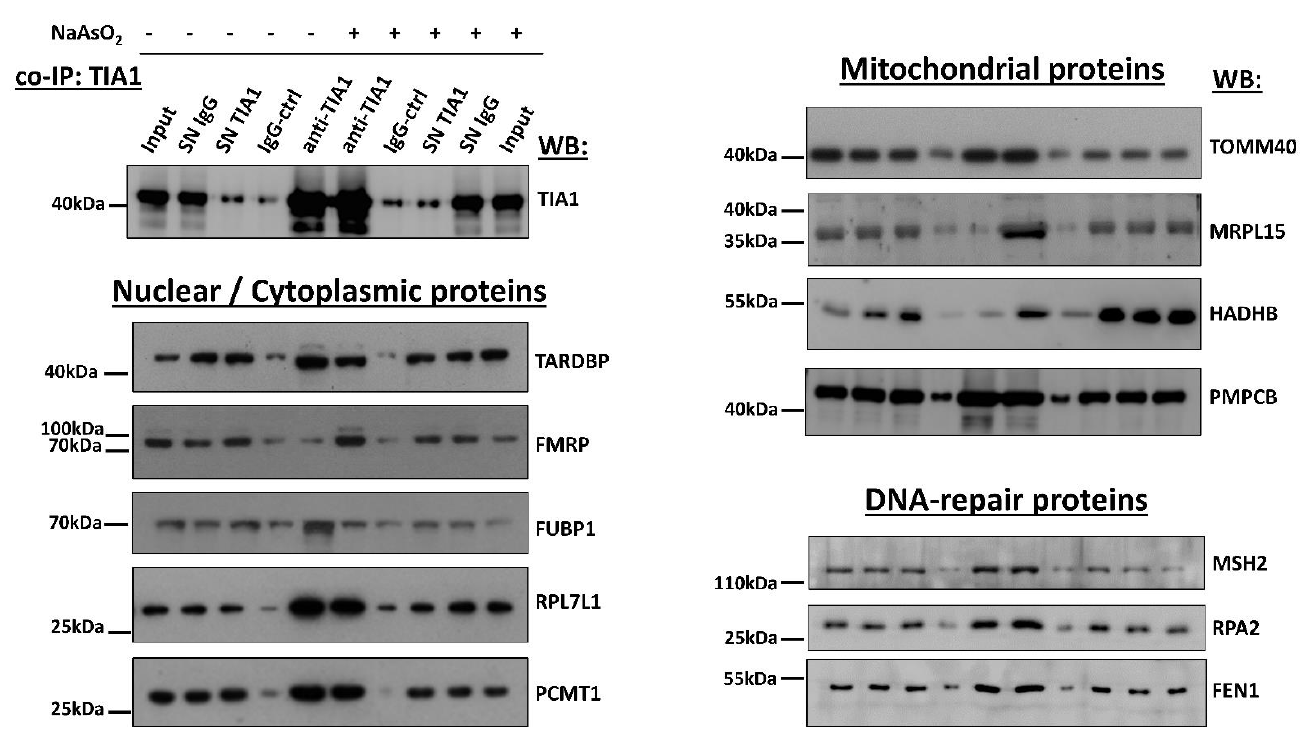
Figure 5. Several protein partners revealed by proximity biotinylation were proved to interact with TIA1 directly. TIA1-overexpressing SK-N-SH cells treated with or without sodium arsenite were subjected to co-immunoprecipitation reactions using anti-TIA1 antibody or IgG as a control. Precipitated proteins and the original lysates (inputs) were analyzed by SDS-PAGE followed by immunoblotting detecting TIA1, TARDBP (TDP43), FMRP FUBP1, RPL7L1, PCMT1, TOMM40, HADHB, PMPCB, MSH2, RPA2, and FEN1. SN: supernatant of the lysate after immunoprecipitation. Please refer to the supplementary material for uncropped Western Blot